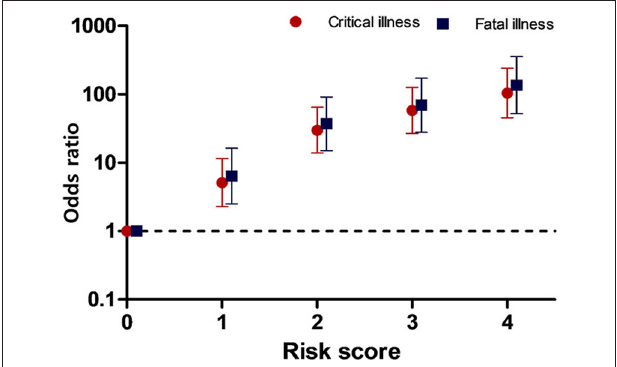
FIGURE 3 | Odds ratios for critical and fatal illness according to the risk score. The scores represent the number of risk factors.